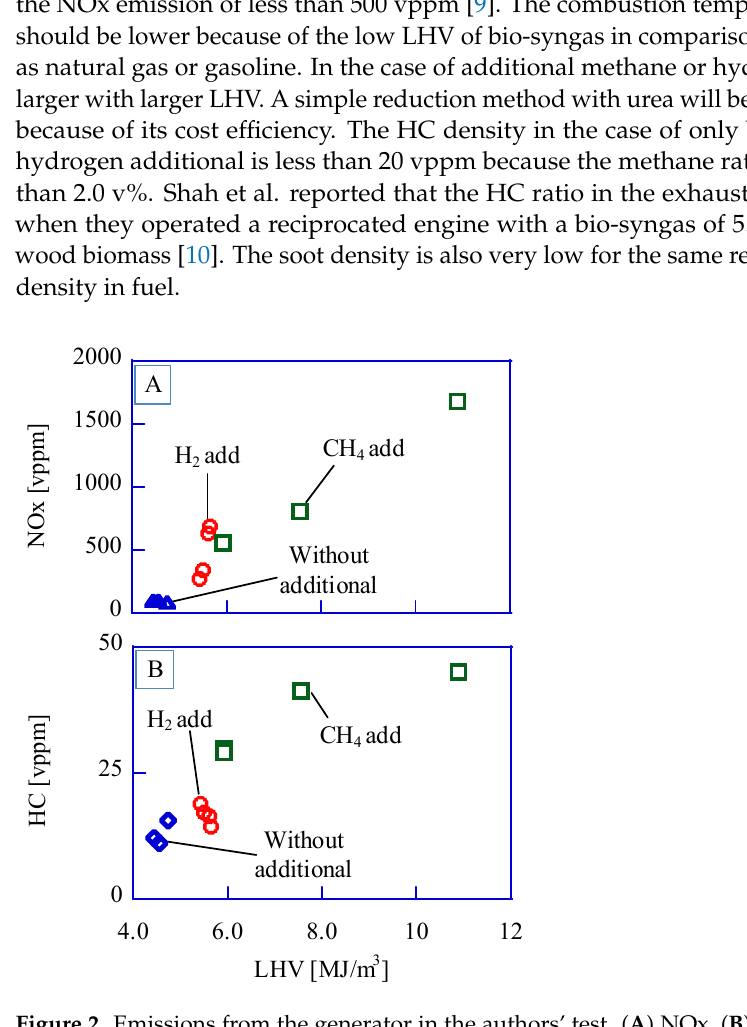
Figure 2. Emissions from the generator in the authors’ test. ( A ) NOx, ( B ) HC. Normal bio-syngas without additional case shows such a low density of NOx and HC that the emission treatment is not necessary.